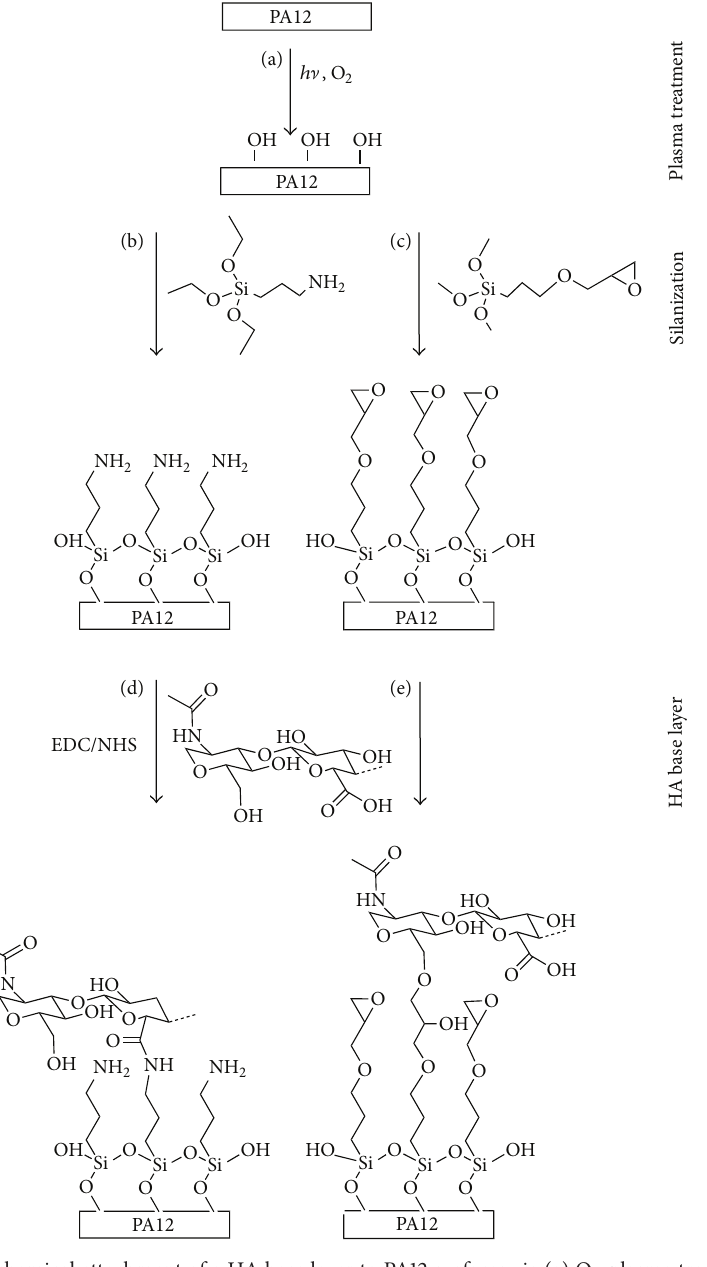
Figure 1: Reaction scheme for chemical attachment of a HA base layer to PA12 surfaces via (a) O 2 -plasma treatment, silanization with (b) APTES or (c) GPTMS, and covalent binding of HA via (d) activation of the carboxylic acid of HA with EDC/NHS and subsequent reaction with terminal amine groups on the APTES-modified PA12 surface or via (e) direct reaction of terminal epoxy groups at the GPTMS-modified PA12 surface and hydroxyl groups of